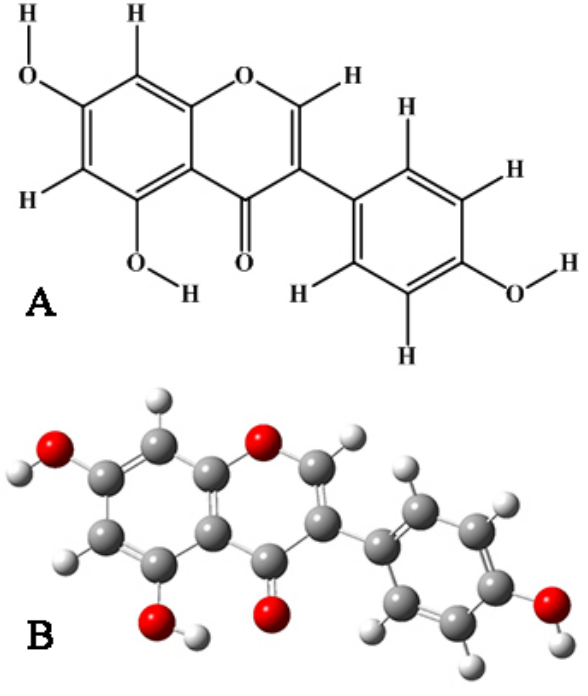
Fig. 6. The structural properties of genistein . (A) Two- dimensional genistein molecular structure. (B) The theoretical geometric structure of genistein. Three-dimensional and optimal structure of genistein for molecular docking assay in MVD soft- ware